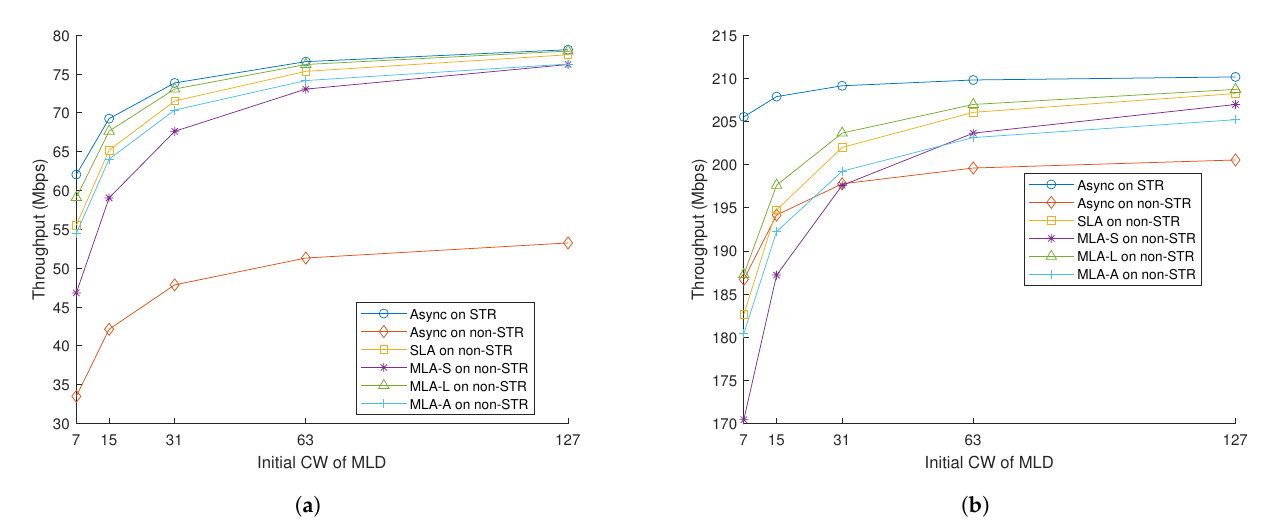
Figure 15. Sum of saturated throughput depending on initial contention window of MLD, ( a ) when RTS/CTS exchange is off, and ( b ) when RTS/CTS exchange is